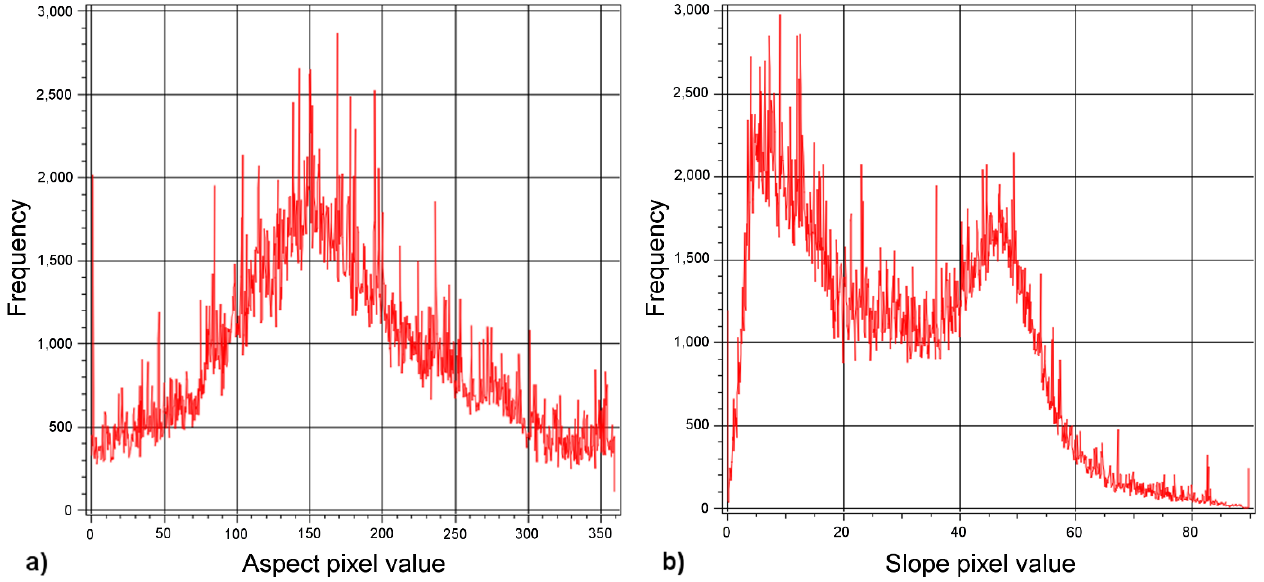
Figure 4. ( a ) Pixel value frequency of the aspect raster that shows the exposure of biancane relief; the highest frequency is between 90 and 220, that is, from E-SE to SW; ( b ) pixel value frequency of the slope raster; although most pixel values are lower than 40°, several pixels have values over 60°, and a secondary peak is visible around a value of 50°.